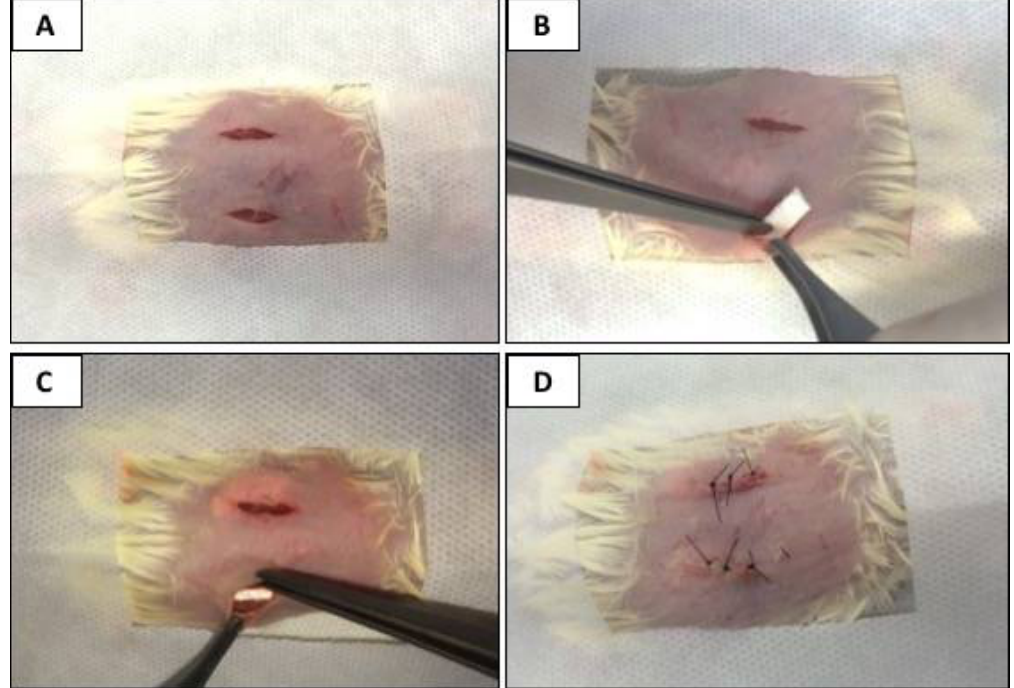
Figure 1. Surgical procedures. ( A ) Trichotomy, sterilized fields affixed, and two rectilinear incisions in the dorsal region of the animal. ( B ) After divulsion, the collagen membrane was implanted. ( C ) Membrane was accommodated in the subcutaneous tissue. ( D ) Suturing.